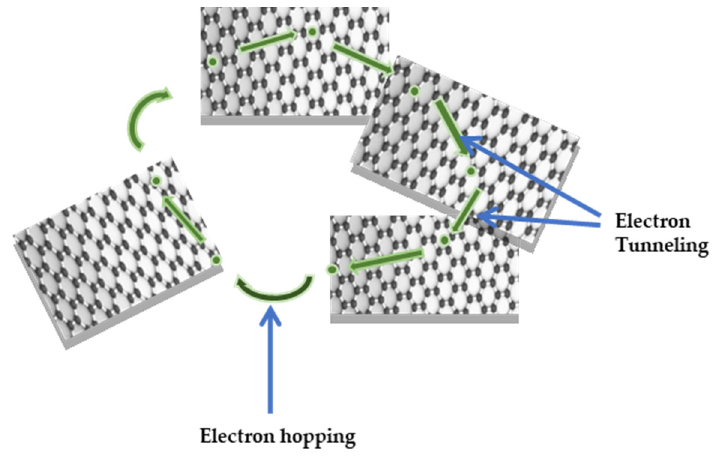
Figure 8. AC conductivity of GO-Ag-PVA nanocomposites as a function of ( a ) GO loading, ( b ) ionic liquid and ( c ) temperature effect on 3GO-Ag-PVA (IL).